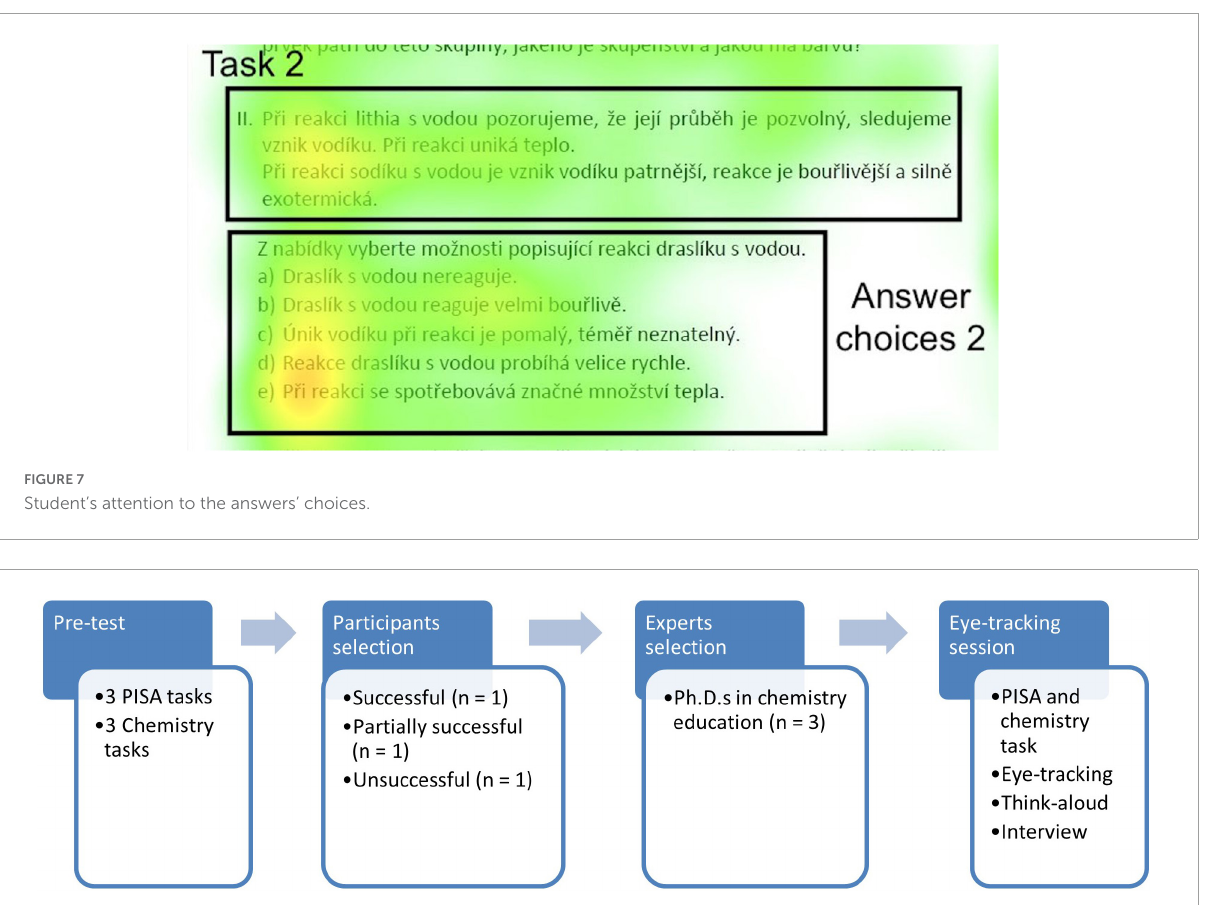
FIGURE8 Expert’s attention to the task itself and answer